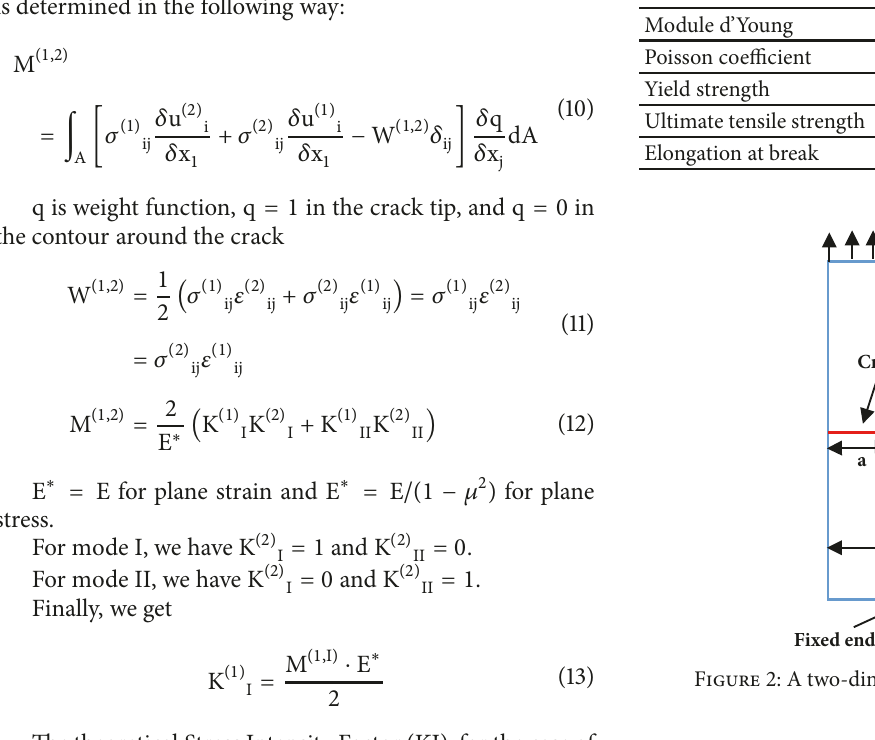
Table 1: Mechanical properties of the material [31].